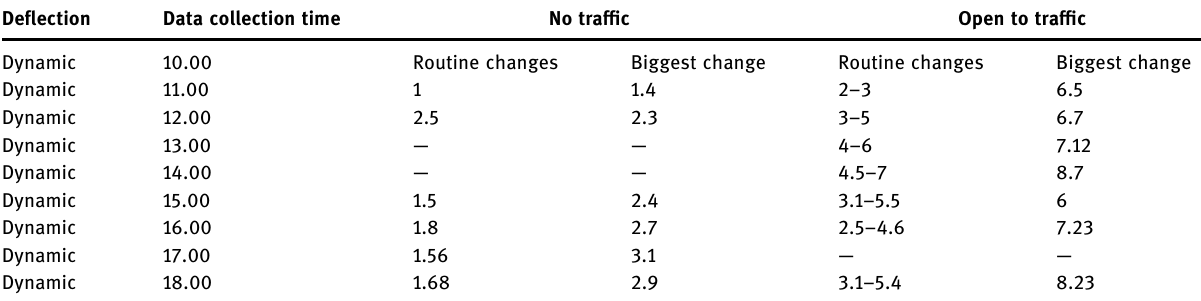
Table 3: Dynamic de fl ection data of the right side of the Gaojia Garden Bridge De fl ection